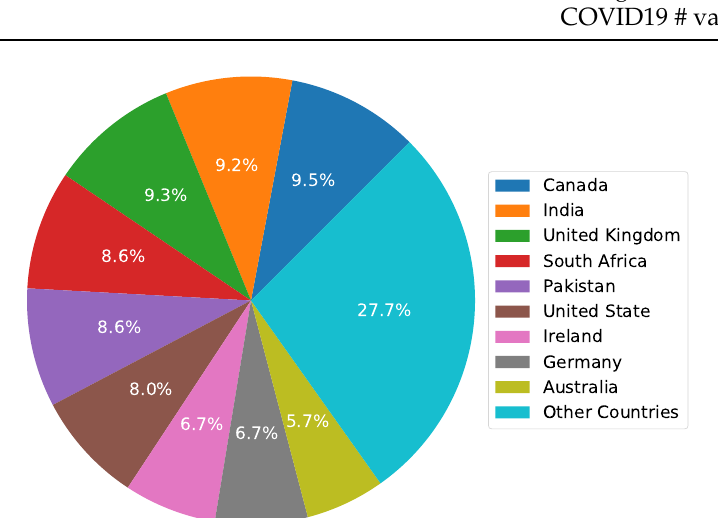
Figure 1. The country-wise number and proportion of